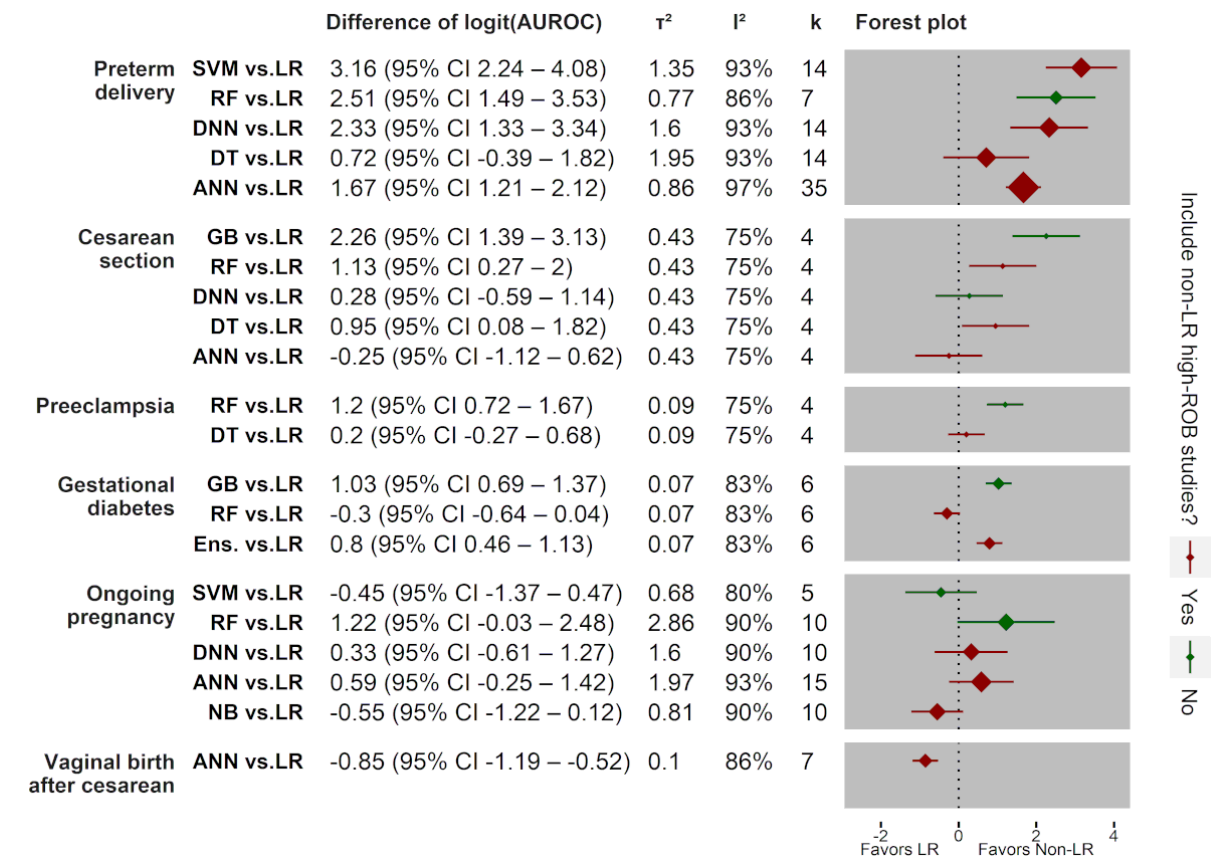
Figure 3. Forest plot of random effects models for differences in logit AUROCs from a non-LR with any LR prediction models. Plots were grouped by outcome. The lines indicate the 95% CI with diamonds whose sizes were determined by the number of pairwise comparisons (k). Absolute and relative values of between-study heterogeneities are denoted by τ 2 and I2, respectively. Colors of the boxes and lines were determined based on the existence of high ROB studies among those using non-LR algorithms. ANN: artificial neural network; AUROC: area under the receiver operating characteristic curve; DNN: deep neural network; DT: decision tree; Ens: ensemble of multiple algorithms; GB: gradient boosting; LR: logistic regression; NB: naïve Bayes; RF: random forest; ROB: risk of bias; SVM: support vector